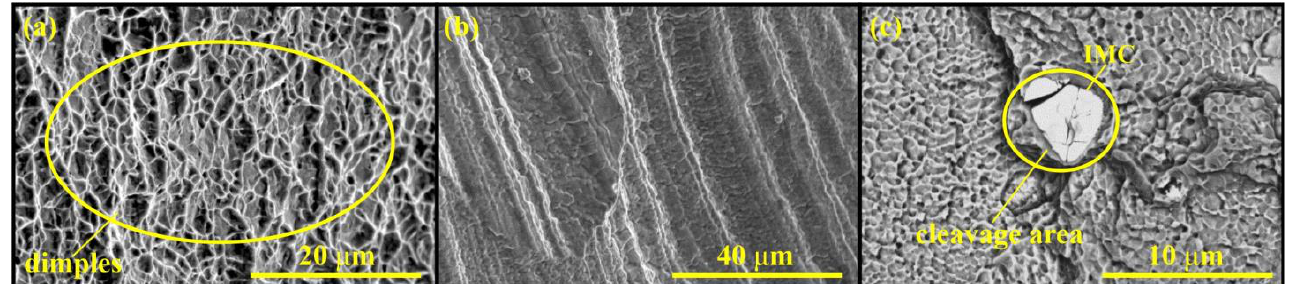
Figure 10. SE/BSE images and results of fractography analysis of Ti-4Al-3Mo-1V — Ti-6Al-4V weld, which was destroyed in area of stir zone at different zoom levels ( a – c ).